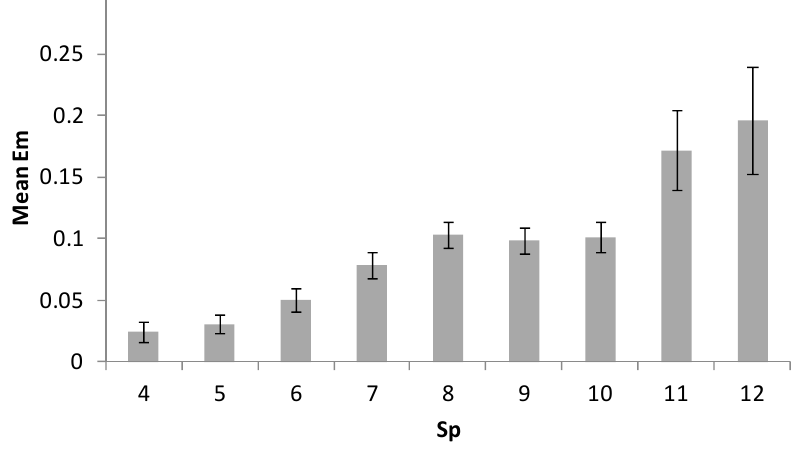
Figure 7. Mean error level per the number of information items, filled cells ( S P ).